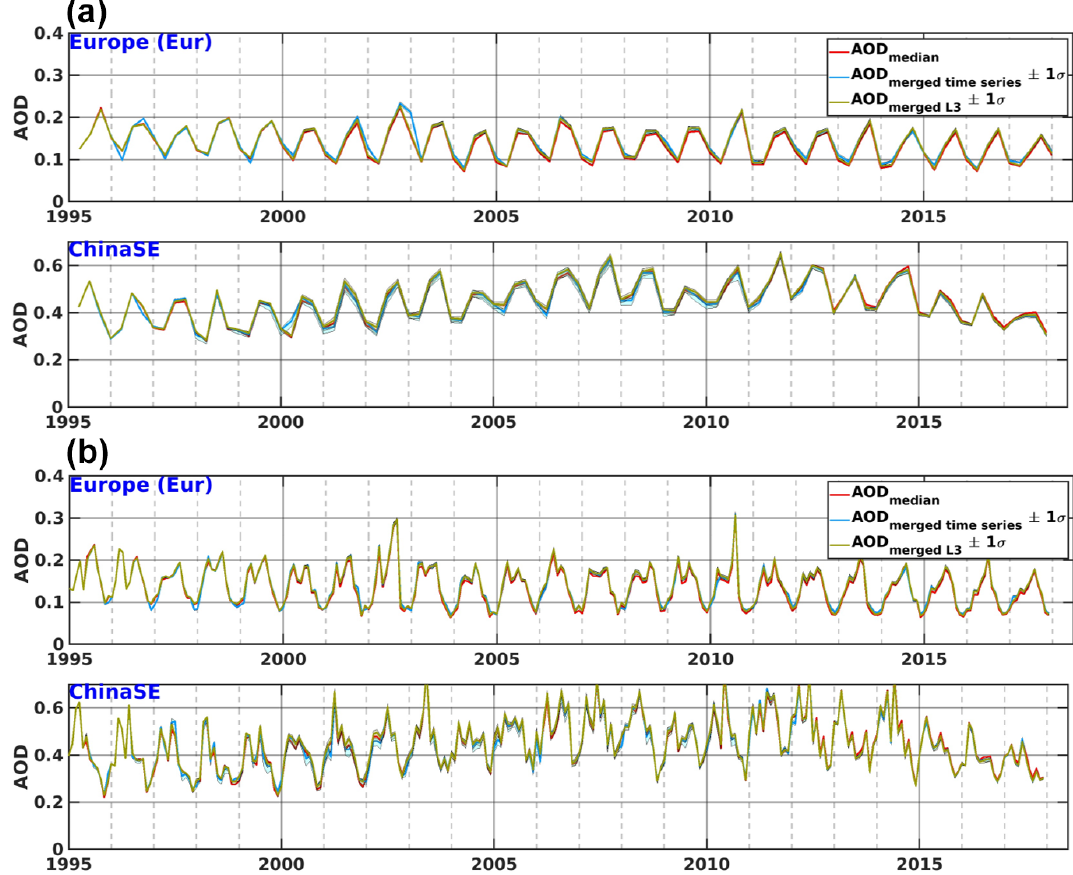
Figure 13. (a) Seasonal and (b) monthly AOD median time series (red), merged time series (blue) and time series from the merged L3 product (olive) for Europe and ChinaSE. AOD ± 1 σ for the merged time series and for the time series from the merged L3 products are shown as light blue and light olive shadows, respectively. Note the different scale. For all selected regions, see Figs. S16 and